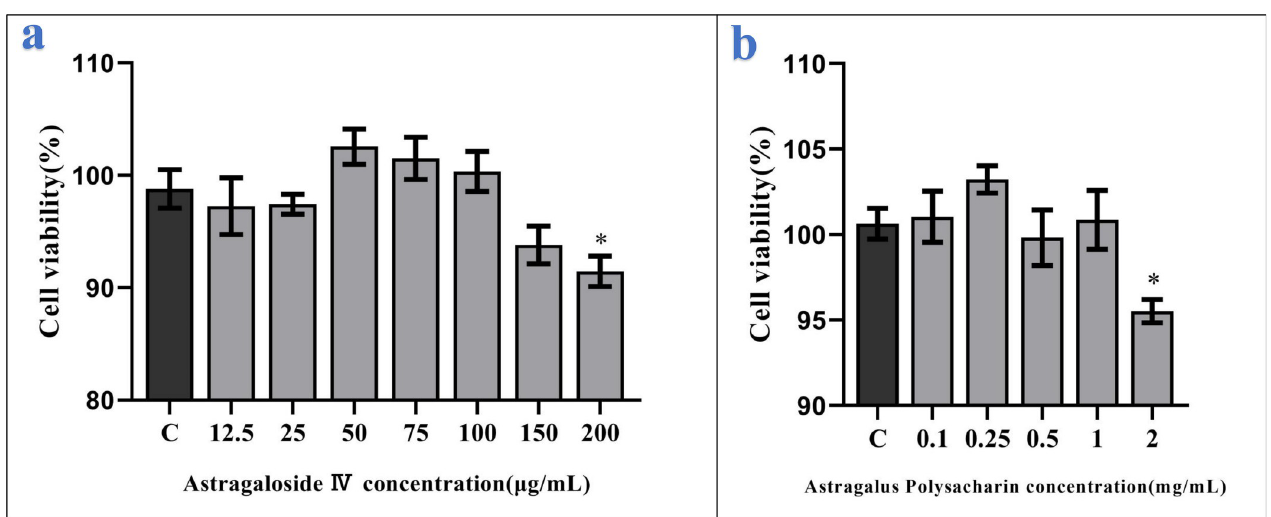
Fig 2. Influence of AS-IV and APS on the biological activity of BMECs. The viability of BMECs treated with the indicated concentrations of AS-IV and APS was determined using the CCK-8 assay. Data are expressed as mean ± SD of 6 independent experiments. � 0.01 < P < 0.05, �� P < 0.01.